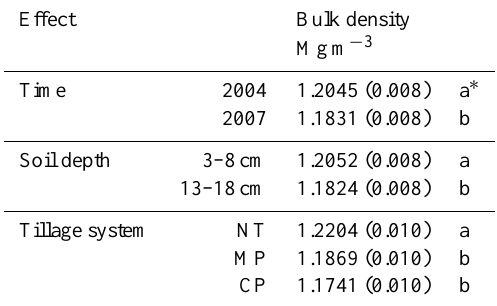
∗ Different letters indicate significant differences at a p